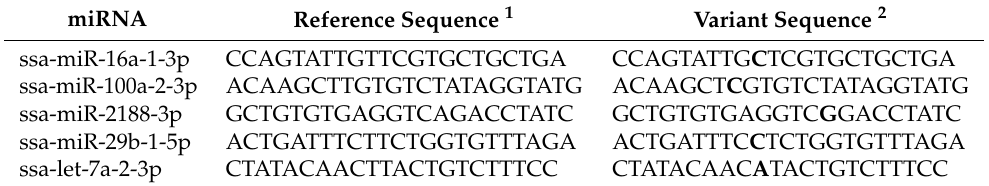
Table 2. Polymorphic variants of canonical mature miRNAs.